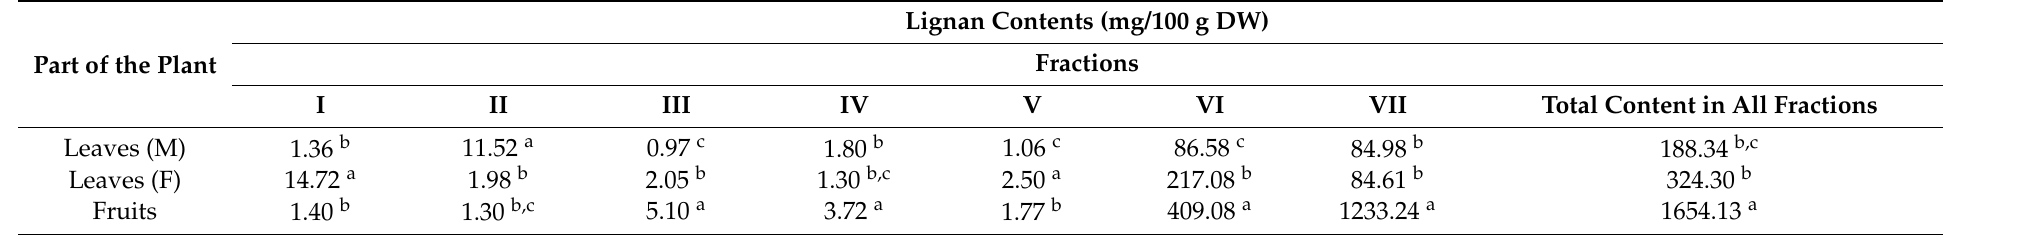
Table 2. Total lignan content in the individual fractions of fruits as well as male (M) and female (F) leaves of S. rubriflora